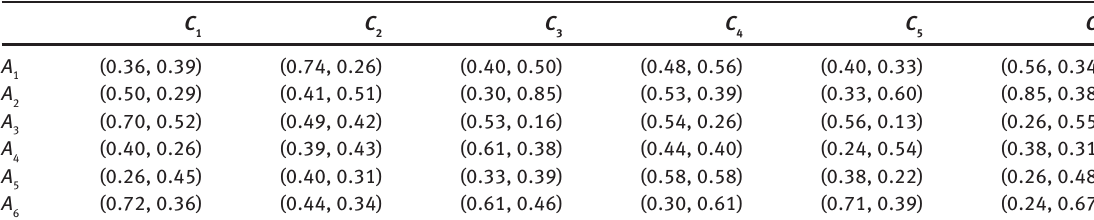
Table 4: Collective Result.